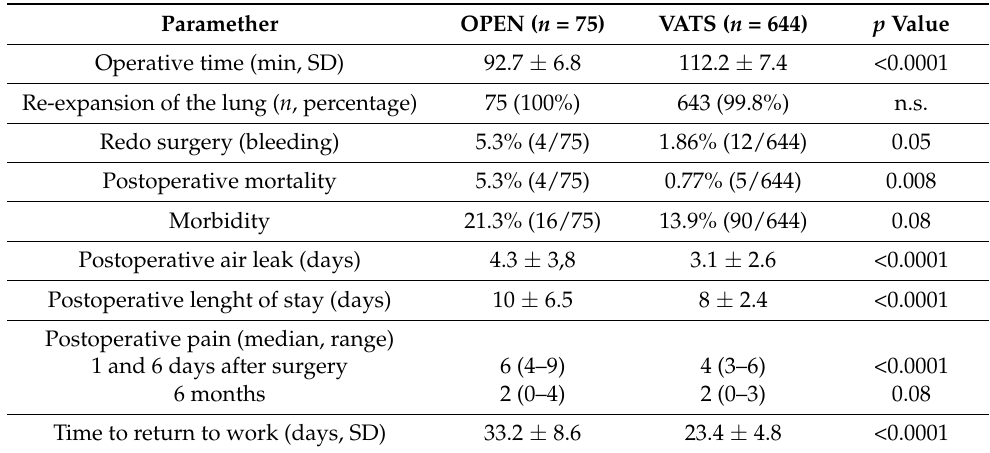
Table 2. Postoperative